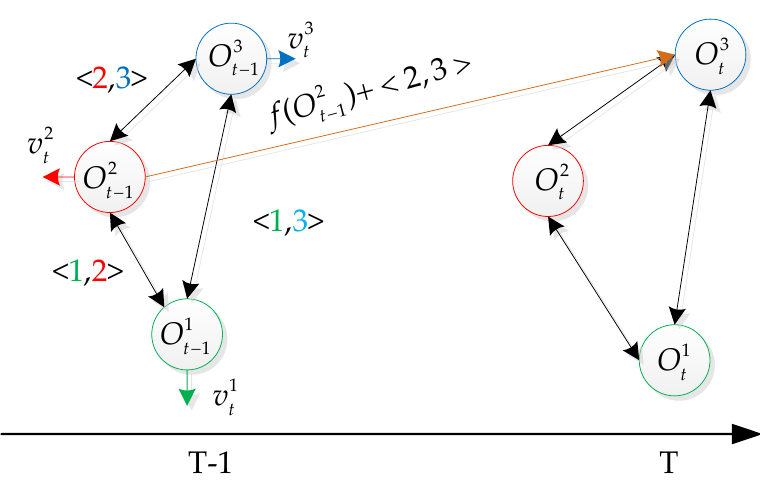
Figure 4. Predicting the target state with the relative-motion model.